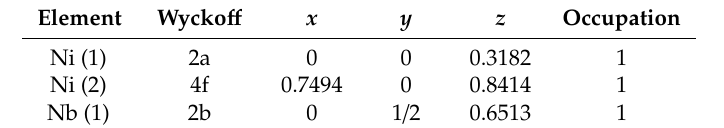
Table 2. Structural parameters of δ phase at 25 °C: Pmmn n°59 with a = 5.114 Å, b = 4.244 Å, and c = 4.538 Å [38].